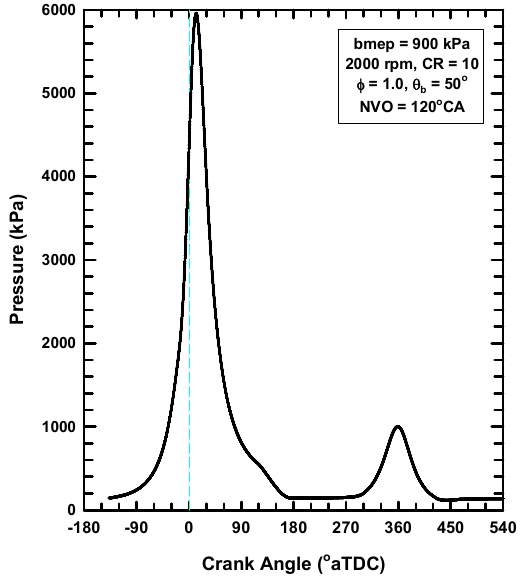
Figure 21. Cylinder pressure as a function of crank angle for a NVO of 120 °CA for case 1.